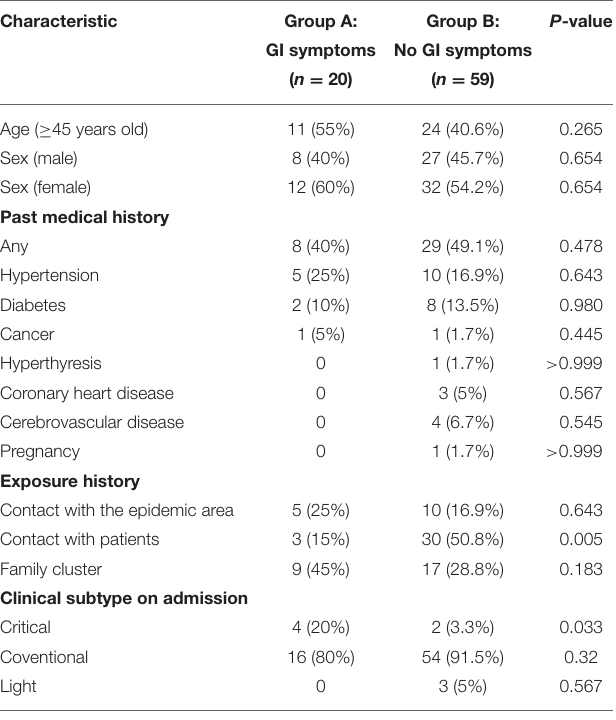
TABLE 2 | Clinical characteristics and selected laboratory abnormalities of patients with COVID-19 with and without GI symptoms. Characteristic Group A: Group B: P -value GI symptoms